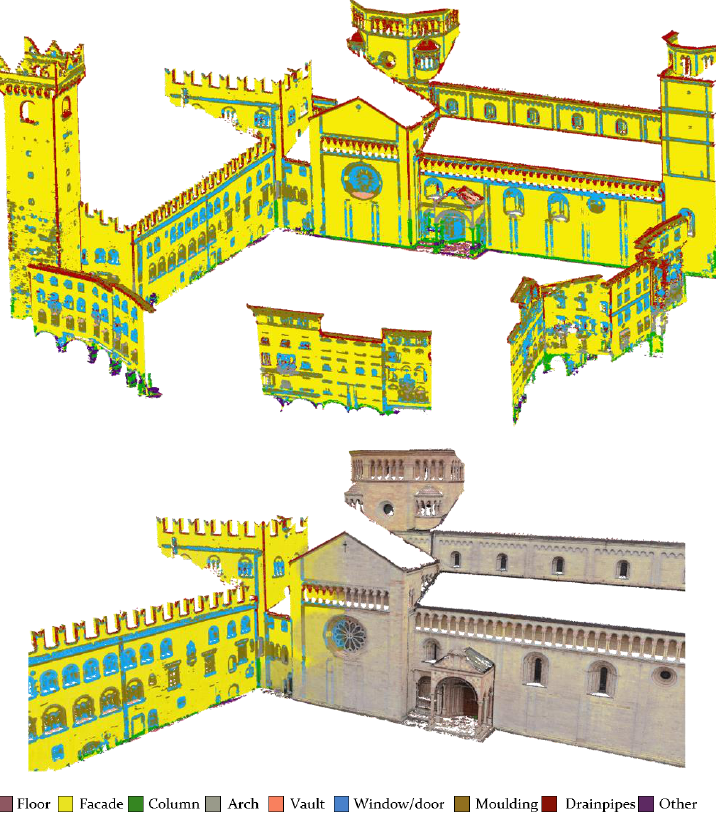
Figure 11. Classification results: generalisation level #3, dataset E. A closer view shows how this architectural style is different from the one in the training dataset (Figure 4). Table 7. Evaluation metrics: generalisation level #4, dataset F. The most critical F1 values are reported in italics ( window and moulding classes).